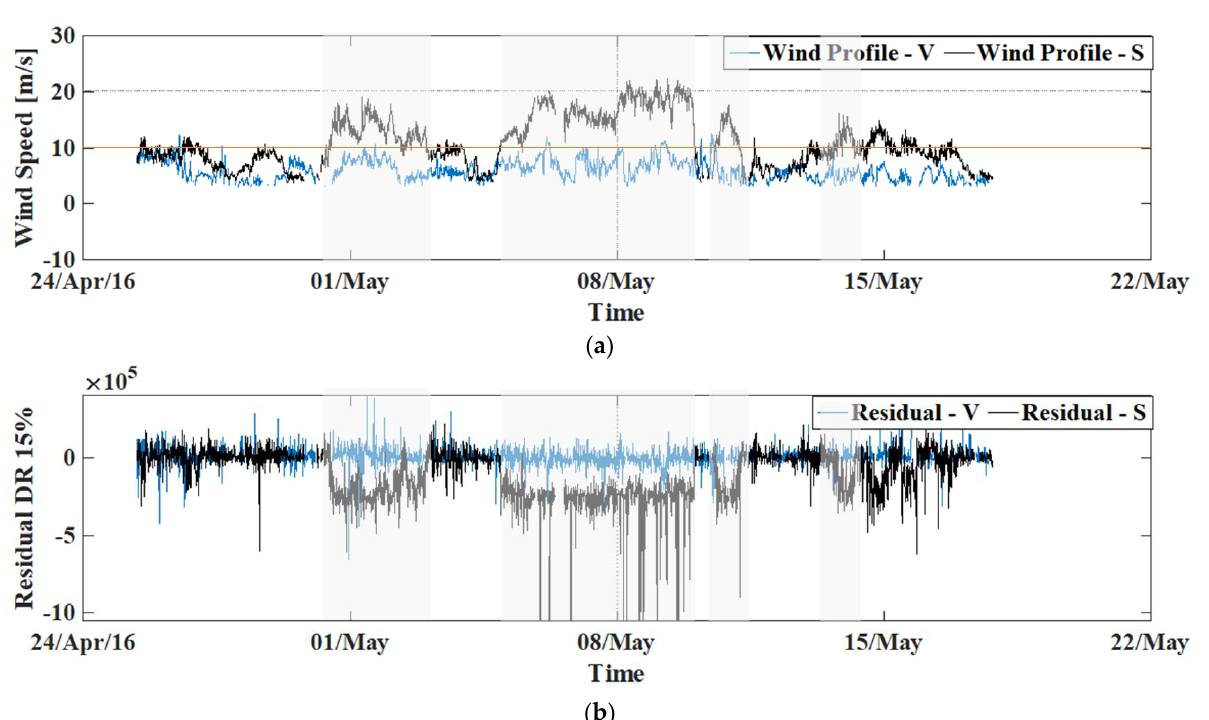
Figure 10. Comparison of Farm V and Farm S over 1 month period ( a ) Wind profiles with red line showing the 10 m/s mark (Periods with high wind speed on Farm S are highlighted gray) ( b ) Residual for Method 1- ‘mono’ for Down-Rating of 15% (Significantly higher activation of fault signature for Farm S is highlighted gray).